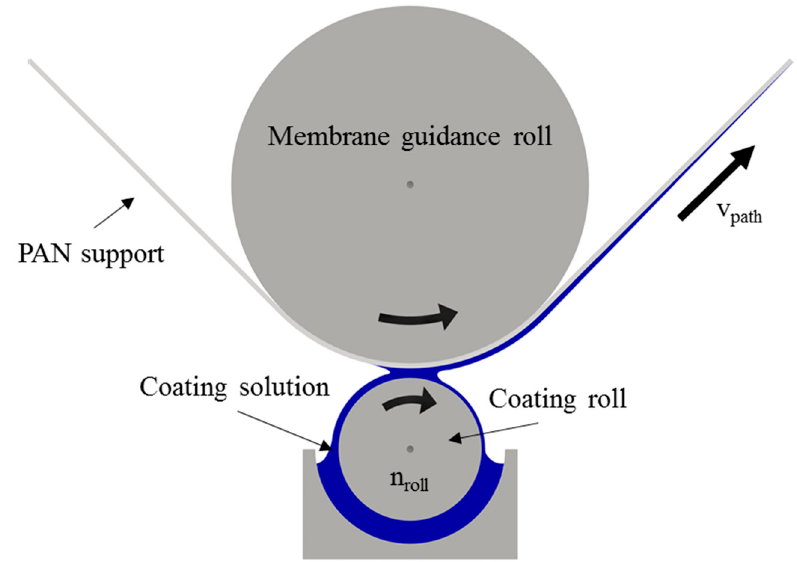
Figure 2. Drawing of the two-roll system of the large-scale dip and roller coating machine. Meniscus formation between the PAN support and coating roll.